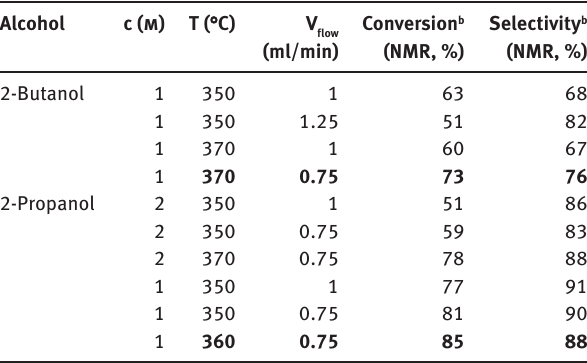
Table 4: Reaction conditions and results with branched alcohols. a Alcohol